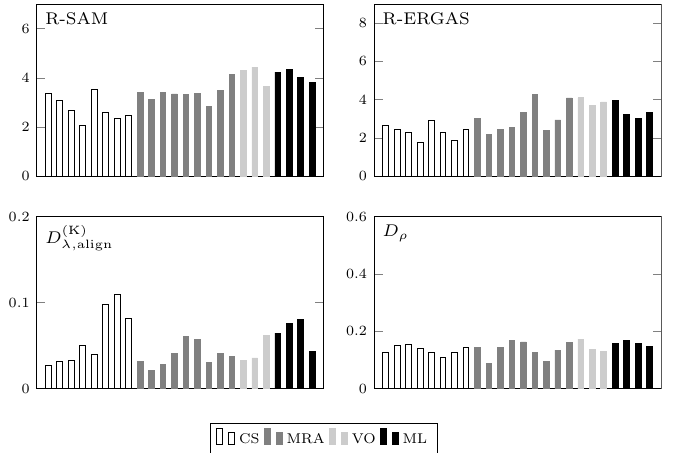
Figure 10. Full-resolution assessment on the WV2 dataset. R- Q 2 n is replaced by its complement D ( K ) for the sake of readability (0 is the ideal value for all). For details on methods and related λ ,align categories (CS, MRA, VO, ML), refer to Table